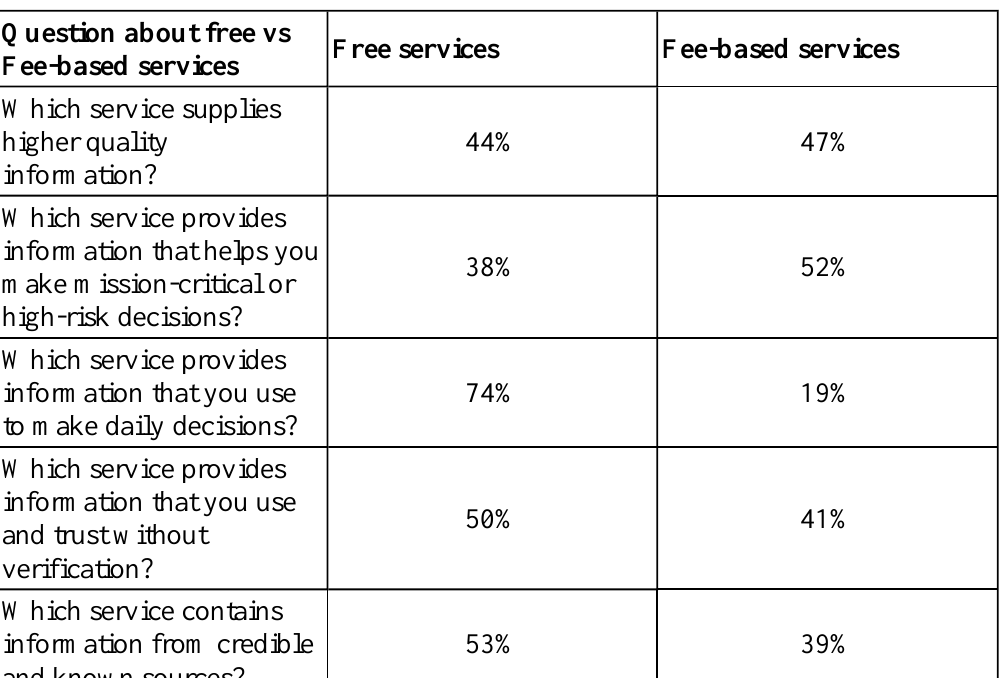
Table 1 Free versus fee-based information services (adapted from Outsell Inc